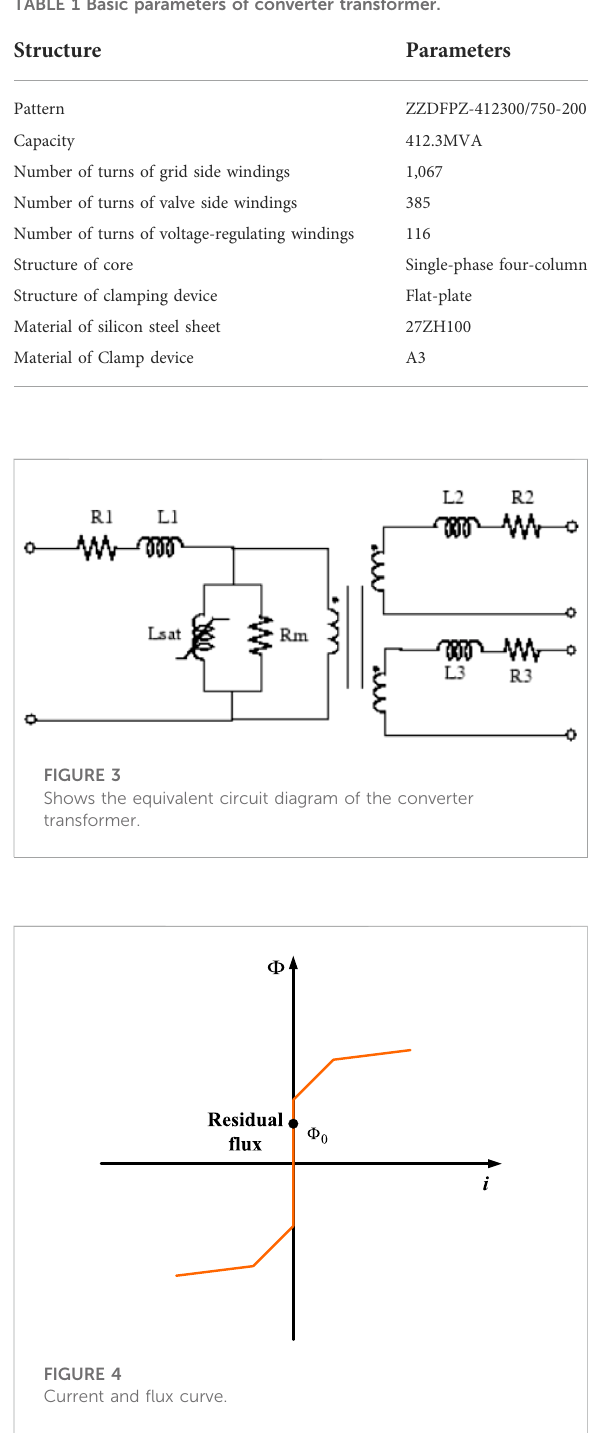
TABLE 1 Basic parameters of converter transformer.